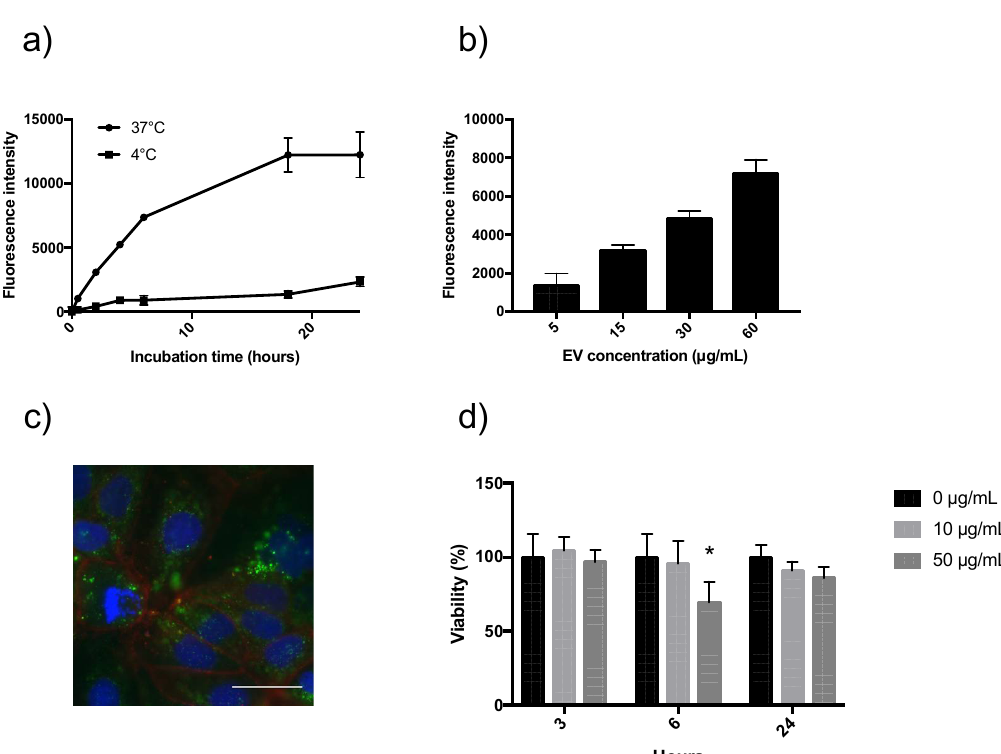
Figure 3. Fluorescently labelled EVs are taken up in vitro by intestinal epithelial cells. Caco-2 cells internalize EVs in an ( a ) time- and temperature-dependent manner (N = 5), and ( b ) in a dose-dependent manner after a four-hour incubation (N = 5). Control measurements (no EVs) are subtracted. ( c ) Uptake of fluorescently labelled EVs (green) after a four-hour incubation was imaged to visualize internalization; blue: DAPI, red: cell membranes Octadecyl Rhodamine B Chloride (R18), green: EVs. Scale bar 10 µm. ( d ) Cytotoxicity of EVs was evaluated using a MTT assay (N = 5). Caco-2 cells incubated with EVs at the indicated times (3, 6, or 24 h) and concentrations (0, 10, or 50 µg/mL). Values are means ± SD; * statistically different from control (0 µg/mL) ( p < 0.05).